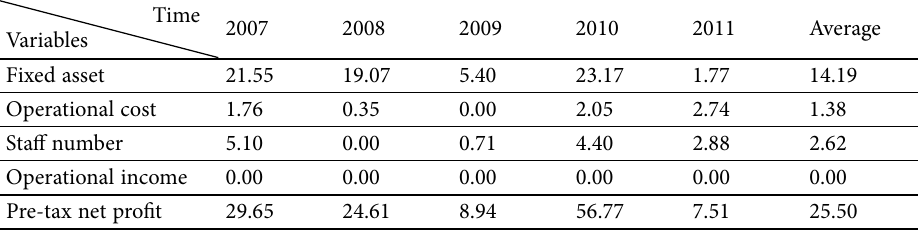
Table 8. 2007–2011 Input output variable difference analysis (unit: